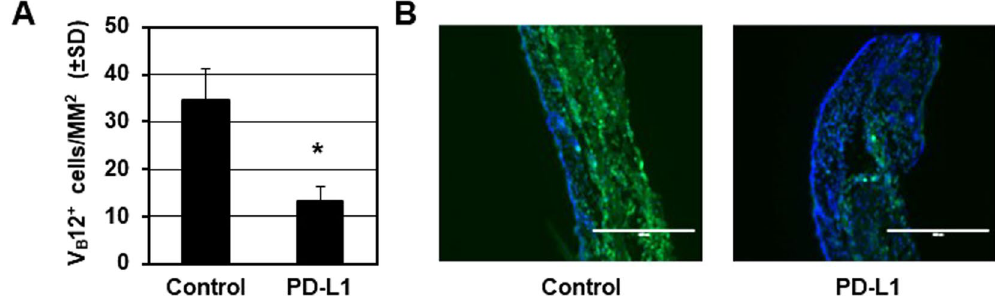
Figure 3. PD-L1 protein reduces melanocyte-specific T cell enrichment in the skin. ( A ) Melanocyte-reactive T cells were detected by immunostaining for the V β 12 TCR subunit in Pmel-1 mice with PD-L1 protein or control with specific anti-VB12 antibodies and then quantified (Control group = 6 cases, PD-L1 fusion protein = 6 cases, * p < 0.05). Representative staining is presented in ( B ). The scale bar represents 400 μ m.